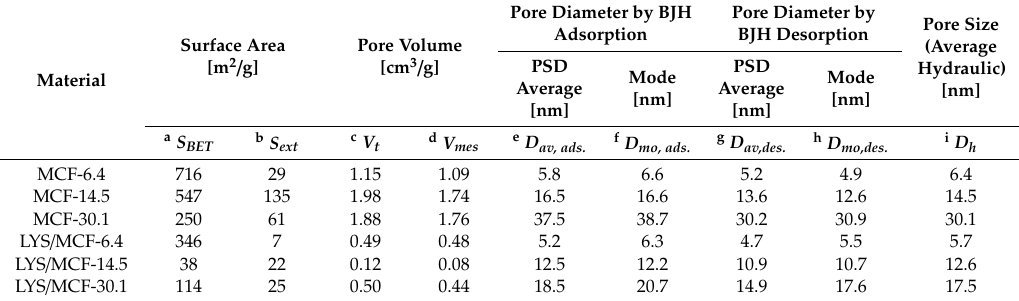
Table 4. Pore structure parameters of the investigated pure supports and biocomposites calculated from N 2 adsorption / desorption isotherms. Adsorption conditions: c 0 = 5 mg / mL; t ads = 24 h; T = 25 ◦ C; pH =